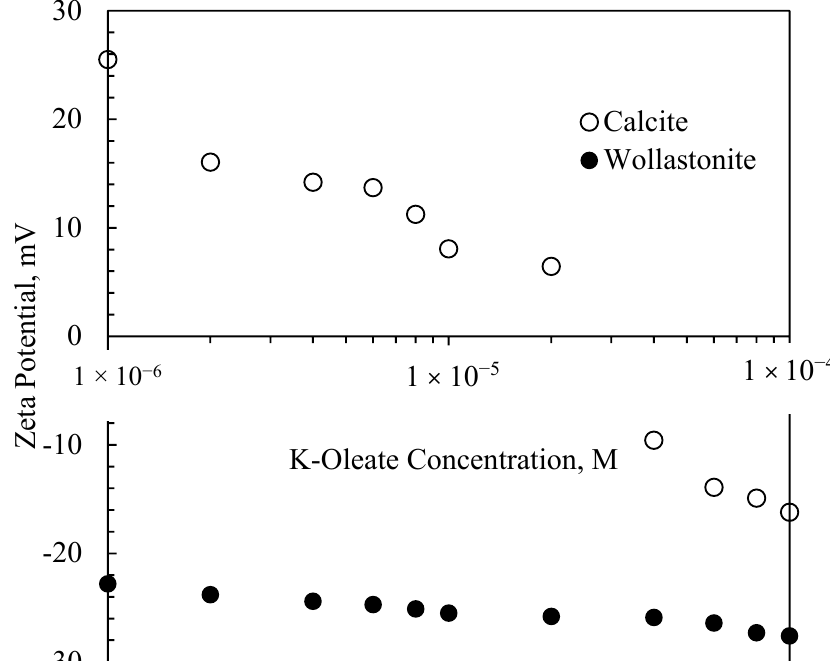
Figure 7. Zeta potential measurements of calcite and wollastonite.